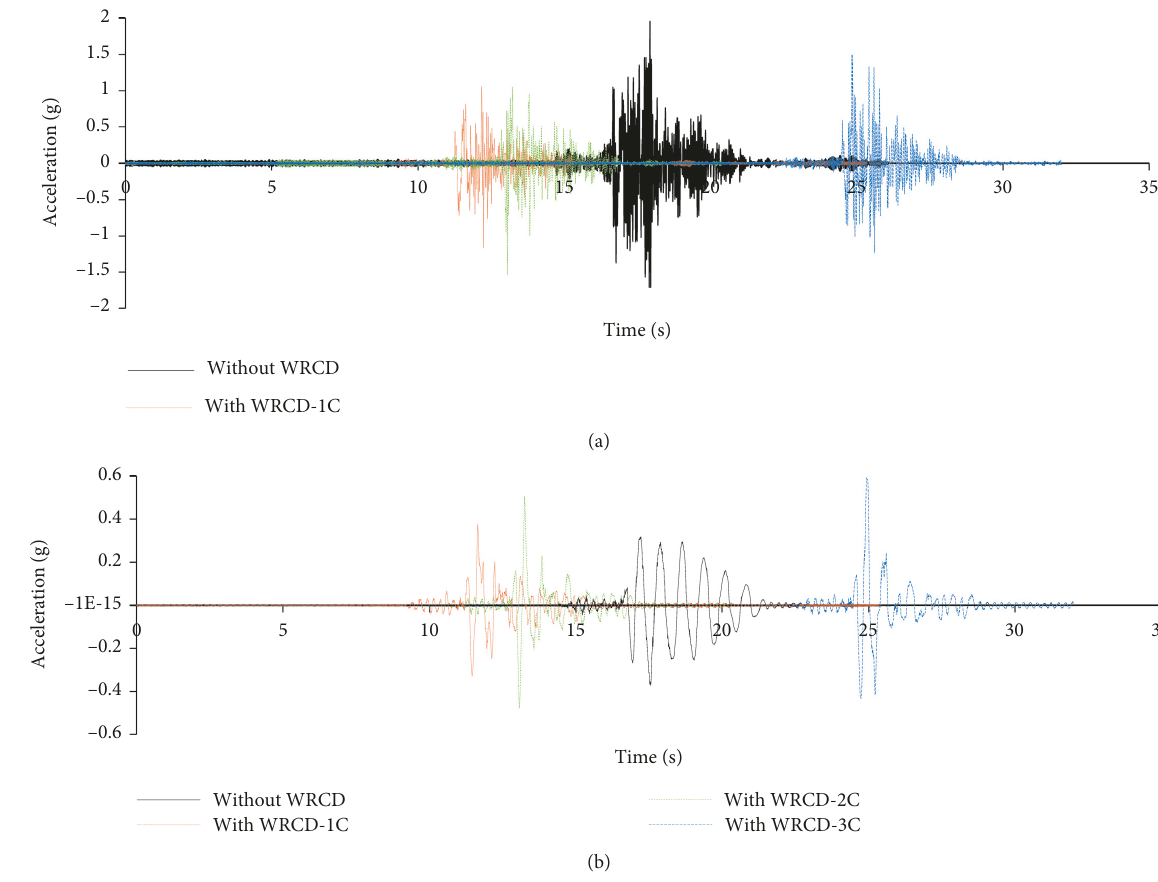
Figure 9: Acceleration time-history curve under Tianjin ground motion. (a) Time-history curve of the acceleration response of the top of active pier #1. (b) Time-history curve of the acceleration response of fixed pier #2.